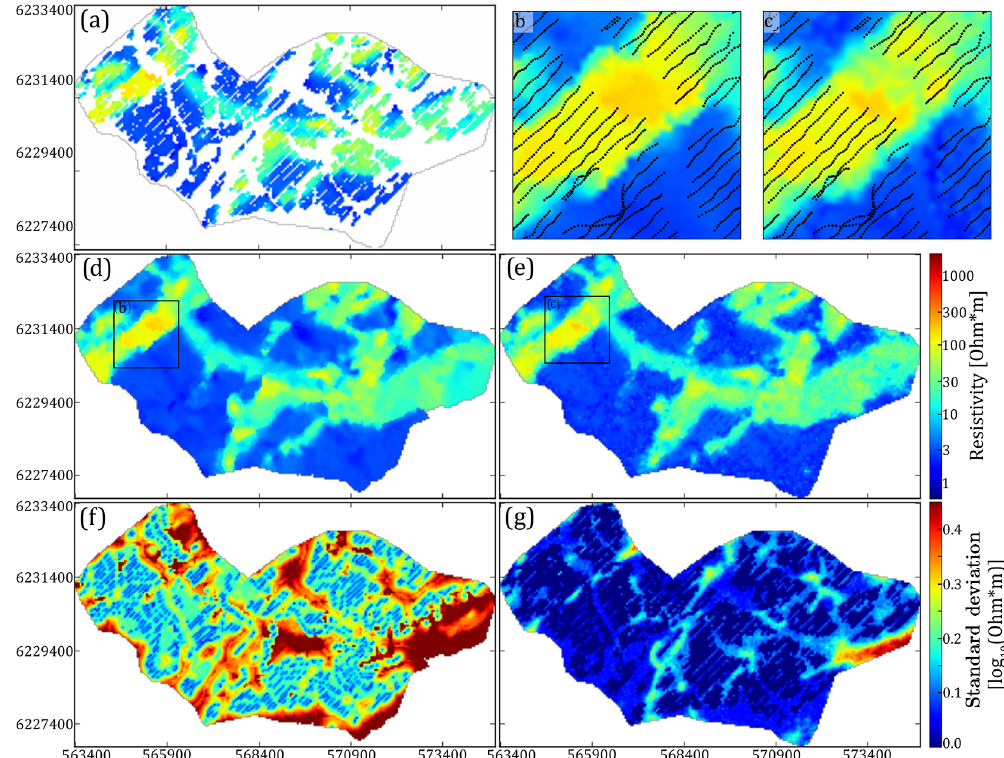
Figure 2. Comparison of the deterministic kriging and stochastic DS resistivity grid reconstruction and their corresponding standard devi- ation. The presented horizontal slice is centered on 20mb.s.l. (a) shows the incomplete resistivity grid using simple kriging with a kriging radius of 50m, (b) shows a close-up of the reconstructed resistivity grid using kriging, (c) shows a close-up of the reconstructed resistivity grid (shown in e ) using DS, (d) shows the full reconstructed resistivity grid using kriging, (e) shows a single realization of the full recon- structed resistivity grid using DS, (f) shows the standard deviation from the reconstructed resistivity grids of (d) using kriging, and (g) shows the standard deviation calculated from an ensemble of 51 stochastic reconstructed resistivity grids using